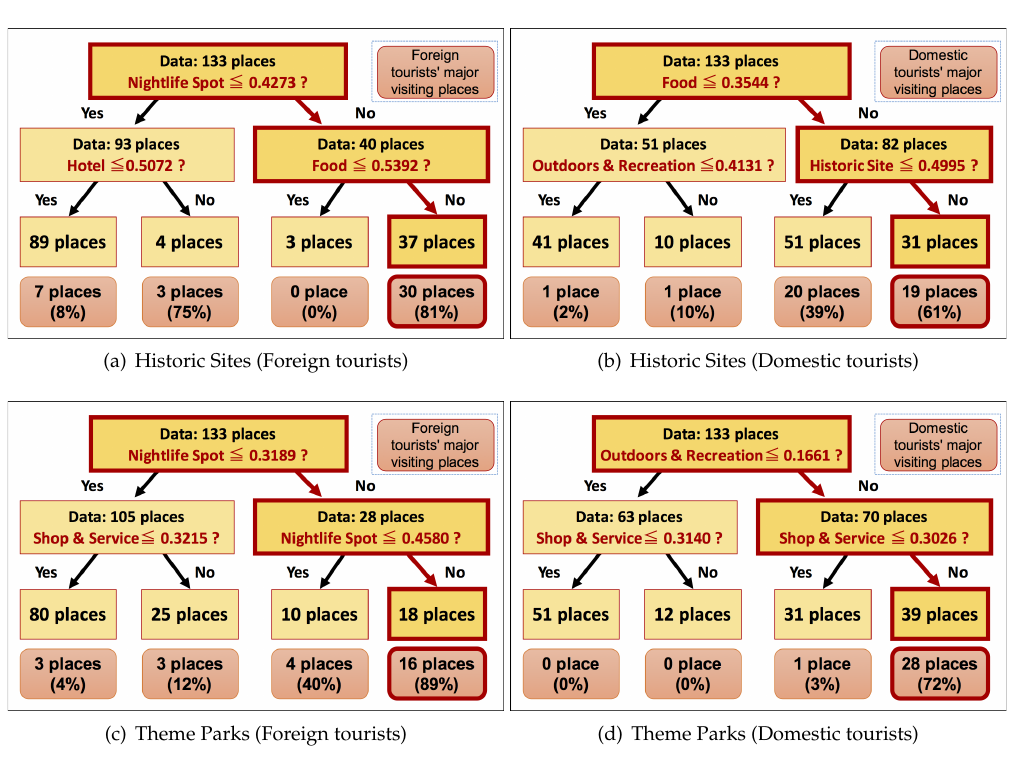
Figure 10. Decision trees of the logarithmic number of tourists: Foreign tourists consider nightlife spots (bars, nightclubs, and night markets) to be important factors around both historic sites and theme parks, whereas domestic tourists do